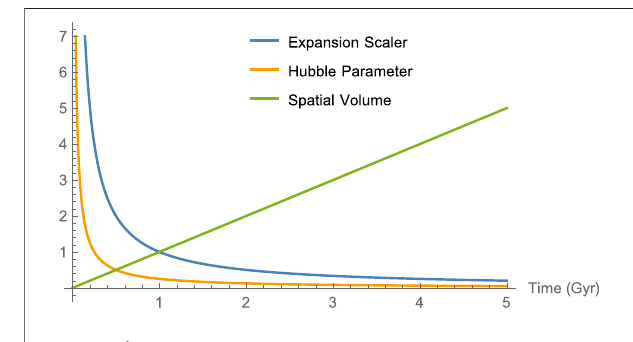
FIGURE 2 | Variation of θ , H, V vs time t